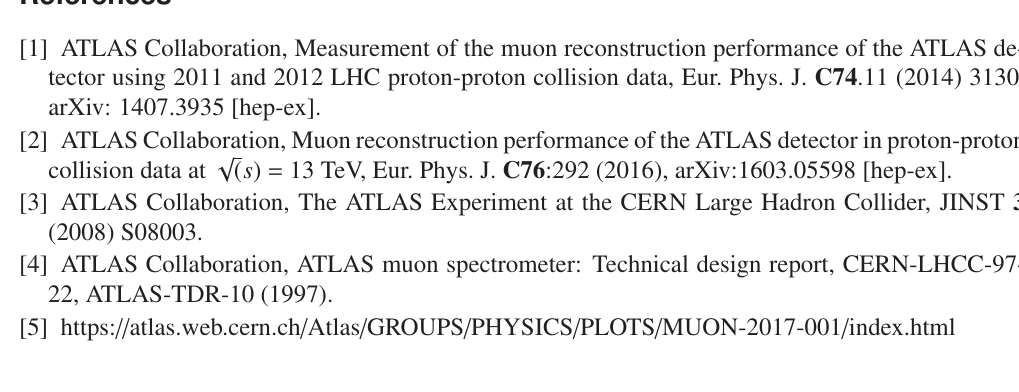
Figure 5. Transverse momentum ( p T ) resolution as a function of pseudorapidity ( η ) obtained from µ + µ − candidates. The dataset, reconstructed Z → consisting of 33.3 fb − 1 of proton-proton collision data collected in 2016 by the ATLAS detector at a centre-of-mass energy of √ s = 13 TeV (filled markers), is compared to prompt Z simulation (continuous line). Muons are reconstructed combining Inner Detector and Muon Spectrometer tracks. Each event must contain two opposite-charge η < 2.5. muons with 22 GeV < p T < 300 GeV and | | The binning is defined according to the η of the leading muon. Figure from [5]. Figure 6. Transverse momentum ( p T ) scale as a function of pseudorapidity ( η ) obtained from µ + µ − candidates. The dataset, reconstructed Z → consisting of 33.3 fb − 1 of proton-proton collision data collected in 2016 by the ATLAS detector at a centre-of-mass energy of √ s = 13 TeV (filled markers), is compared to prompt Z simulation (continuous line). Muons are reconstructed combining Inner Detector and Muon Spectrometer tracks. Each event must contain two opposite-charge η < 2.5. muons with 22 GeV < p T < 300 GeV and | | Figure from [4]. The binning is defined according to the η of the leading muon.